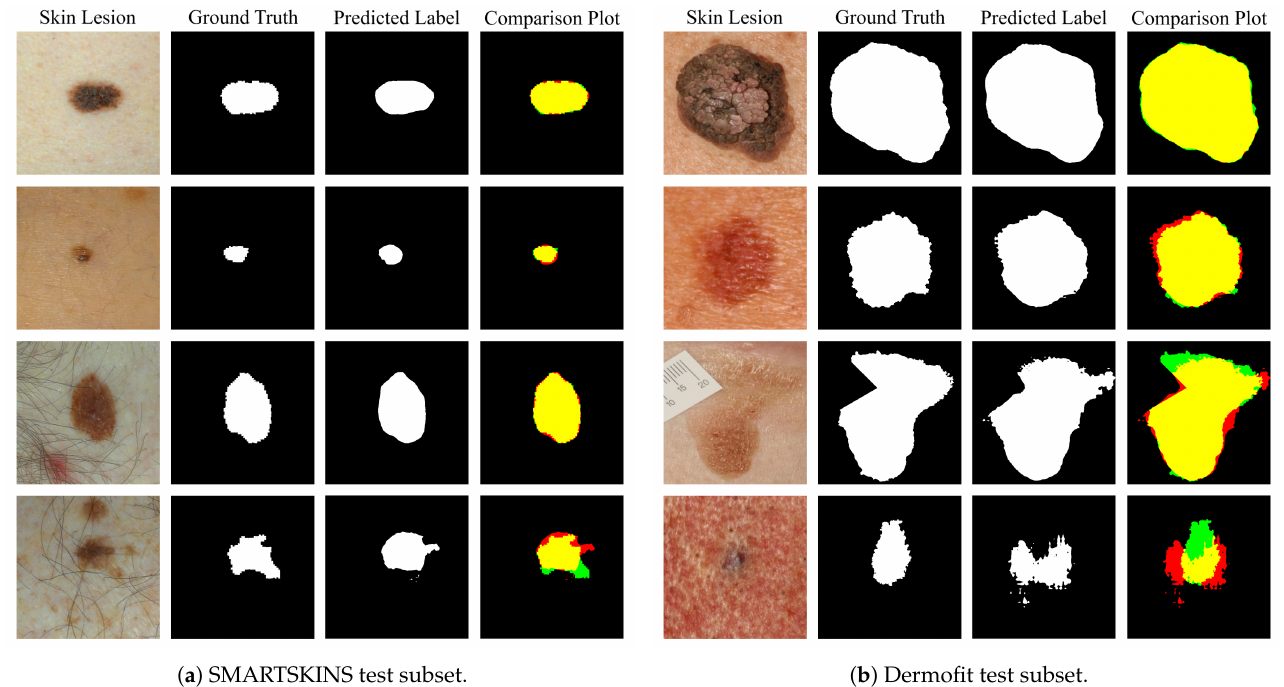
Figure 7. Segmentation results of the Set M + Set M artificial from the tests subsets. In the comparison images: yellow —true positives; red —false positives; green —false negatives; black—true